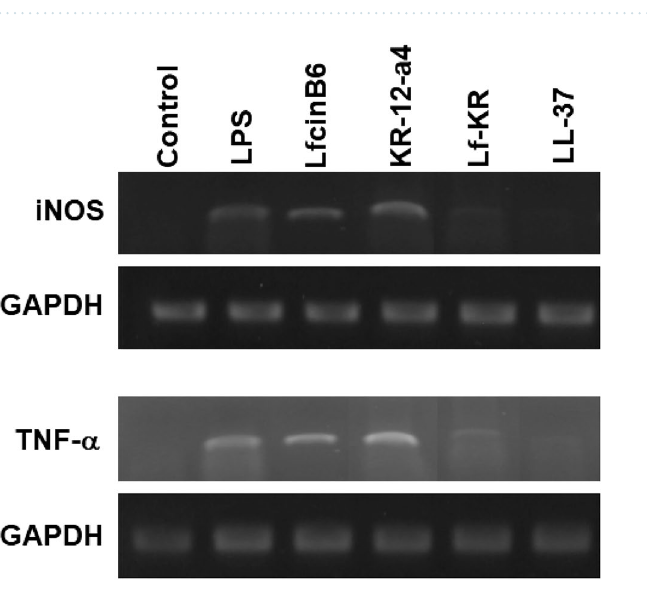
Figure 5. ( a ) Effects of LfcinB6, KR-12-a5, Lf-KR, and LL ‐ 37 on nitric oxide (NO) production in LPS- stimulated RAW264.7 cells. ( b ) Effects of LfcinB6, KR-12-a5, and Lf-KR on TNF-α release from LPS-stimulated RAW264.7 cells. All data represent at least three independent experiments and are expressed as mean ± standard error of the mean (SEM). Data were analyzed by one-way ANOVA with Bonferroni’s post-test. Asterisks indicate statistically significant differences (*P < 0.001 for each agonist). Results were similar when the experiments were repeated using different cells. Peptide concentration is 4 μM.